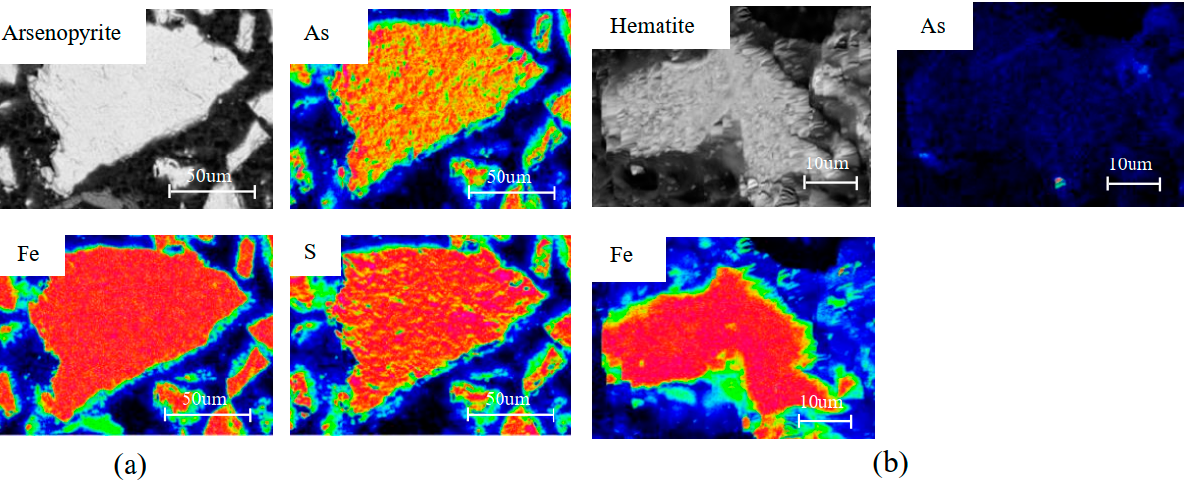
Figure 9. The electron probe microanalysis of arsenopyrite ( a ) and hematite in calcine ( b ).